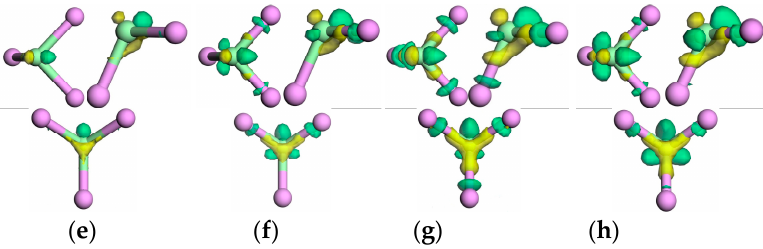
Figure 9. The charge density differences (CDDs) of doped phosphorenes with different impurity atoms: ( a ) P63Al1, ( b ) P62Al2, ( c ) P61Al3, ( d ) P60Al4, ( e ) P63Al1, ( f ) P62Cl2, ( g ) P61Cl3, and ( h ) P60Cl4. The gold and green represent electron accumulation and electron depletion, separately. The value of isosurface is 0.05 e/Å 3 .